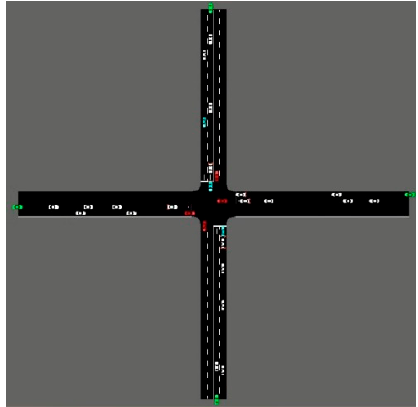
Figure 3. A typical A simulation of urban mobility (SUMO) at a non-signalized intersection.